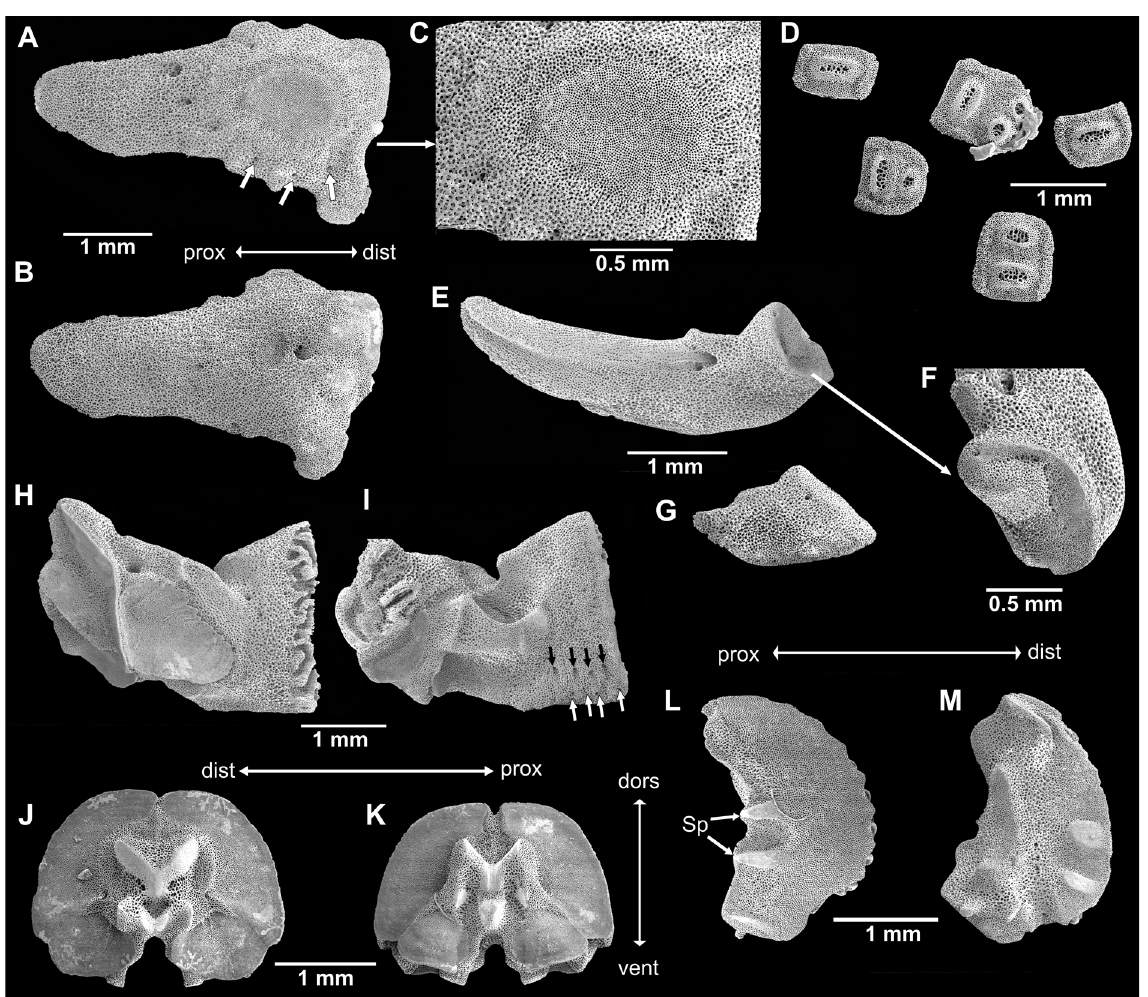
Fig. 12. SEM images of skeletal elements of Ophioderma zibrowii sp. nov., from non-type specimen of 15.4 mm disc diameter (SMNH-178455), Crete, Greece. A . Radial shield, external aspect, white arrows point to larger peripheral pores. B . Radial shield, internal aspect. C . Scale-free part magnified from Fig. 12A, note the absence of pores on the denser area (naked in intact animal, see Fig. 11A). D . Dental plate fragments. E . Adradial genital plate, lateral aspect. F . Distal end of Fig. 12E. G . Abradial genital plate. H . Oral plate, abradial face. I . Oral plate, adradial face, black arrows point to oral papillae sockets and pores. J . Arm vertebra, proximal face. K . Arm vertebra, distal face. L . Lateral arm plate, external face. M . Lateral arm plate, internal face. Abbreviations: dist = distal; dors = dorsal; prox = proximal; Sp = spurs; vent =